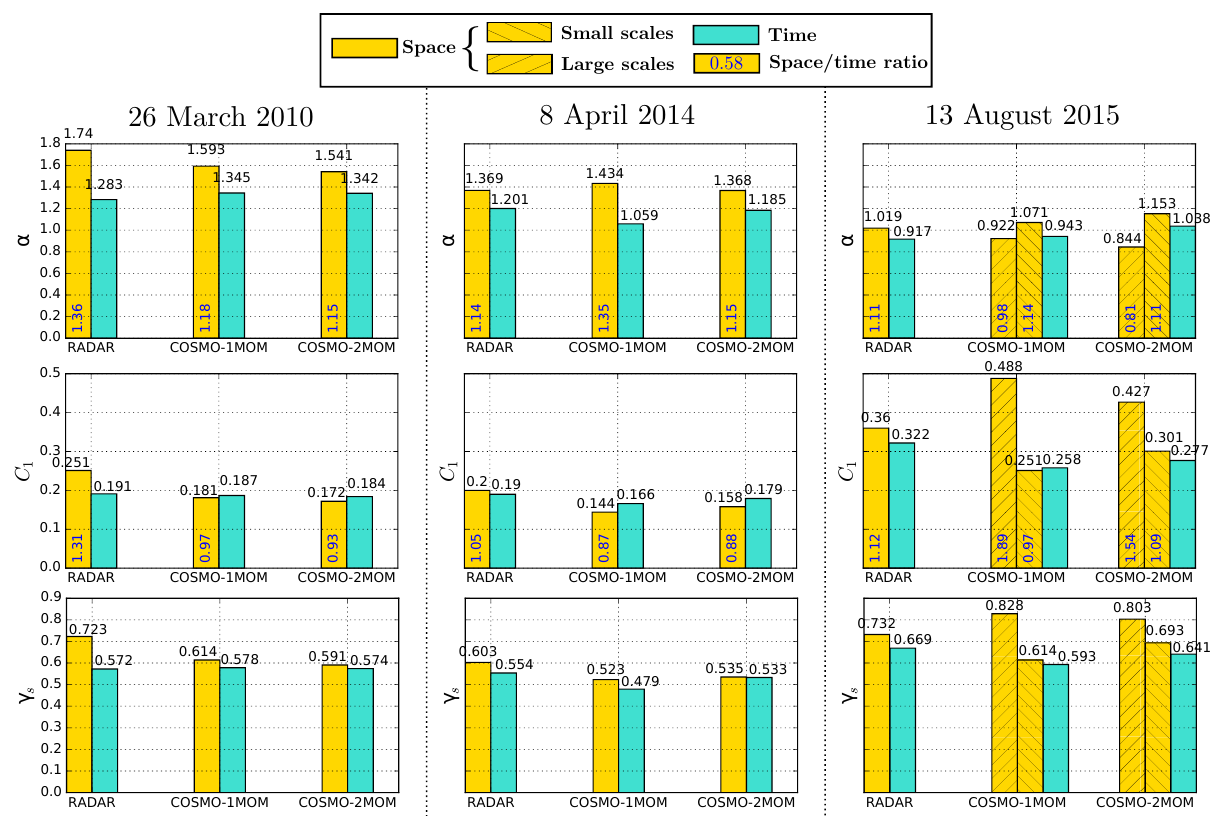
Figure 9. α , C 1 and γ s parameter values obtained with an analysis in time and space on the fluctuations of the precipitation intensities for the three events. For the last event, both the parameters at large and small spatial scales are displayed. The numbers in blue are the space/time ratios for α and C 1